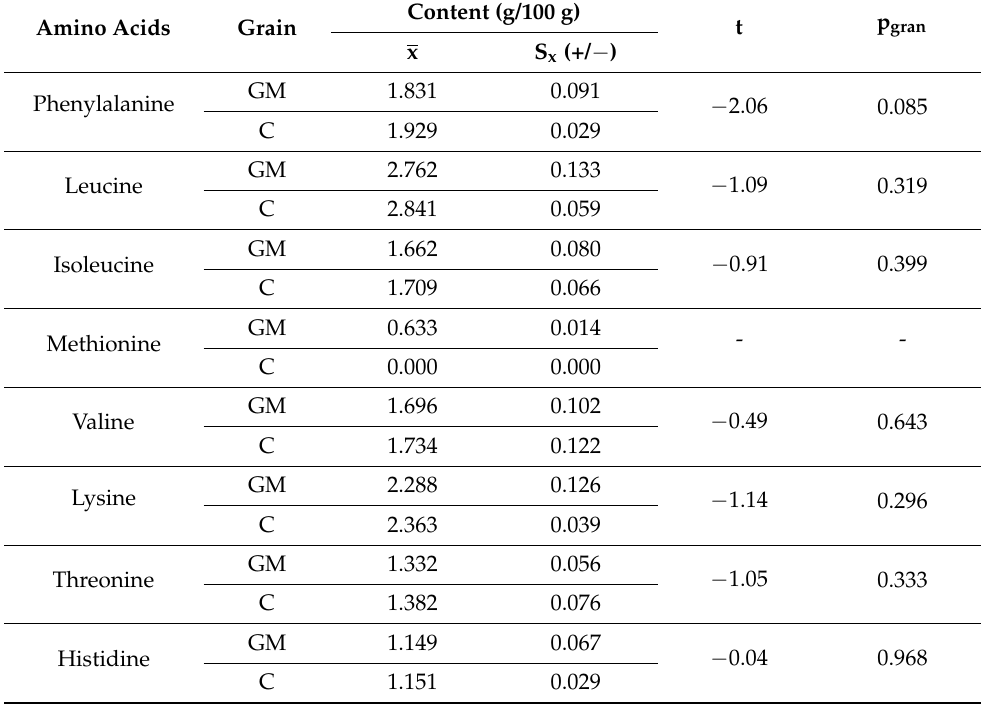
Table 2. Profile and content of exogenous amino acids in conventional and GM soybean grain. Amino Acids